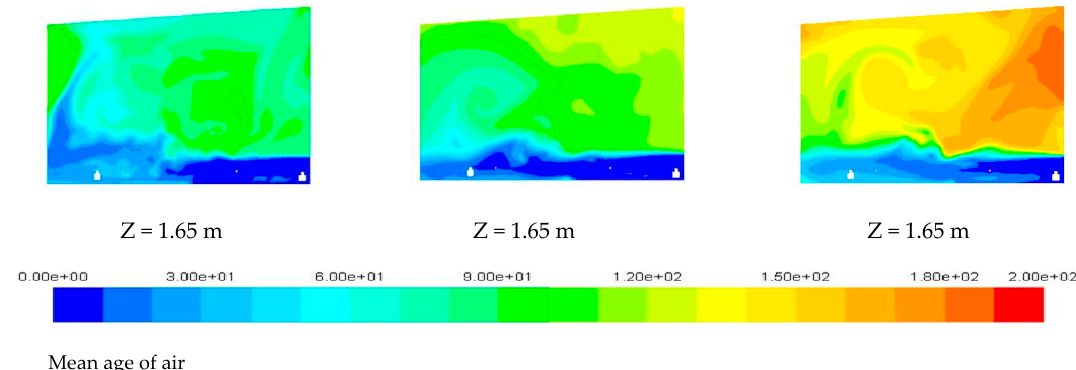
Figure 13. The contours of the age of air in the chamber with broilers.